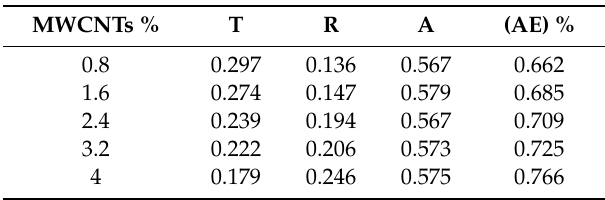
Table 5. The results of the power balance of MWCNT/PLA/PEG nanocomposites as a function of MWCNTs content.